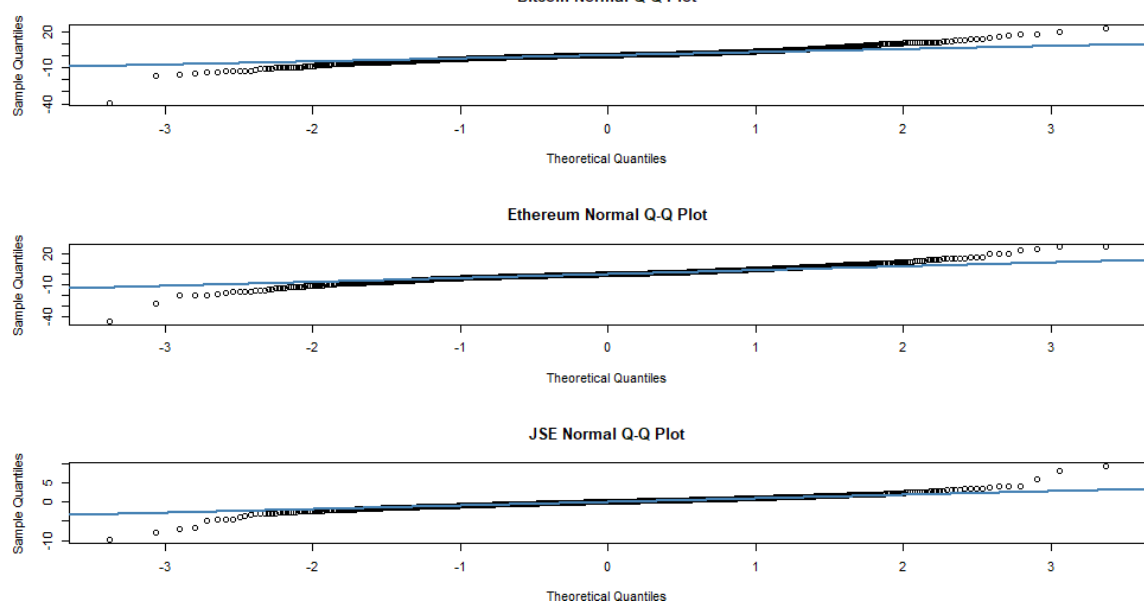
Figure 3. Daily log